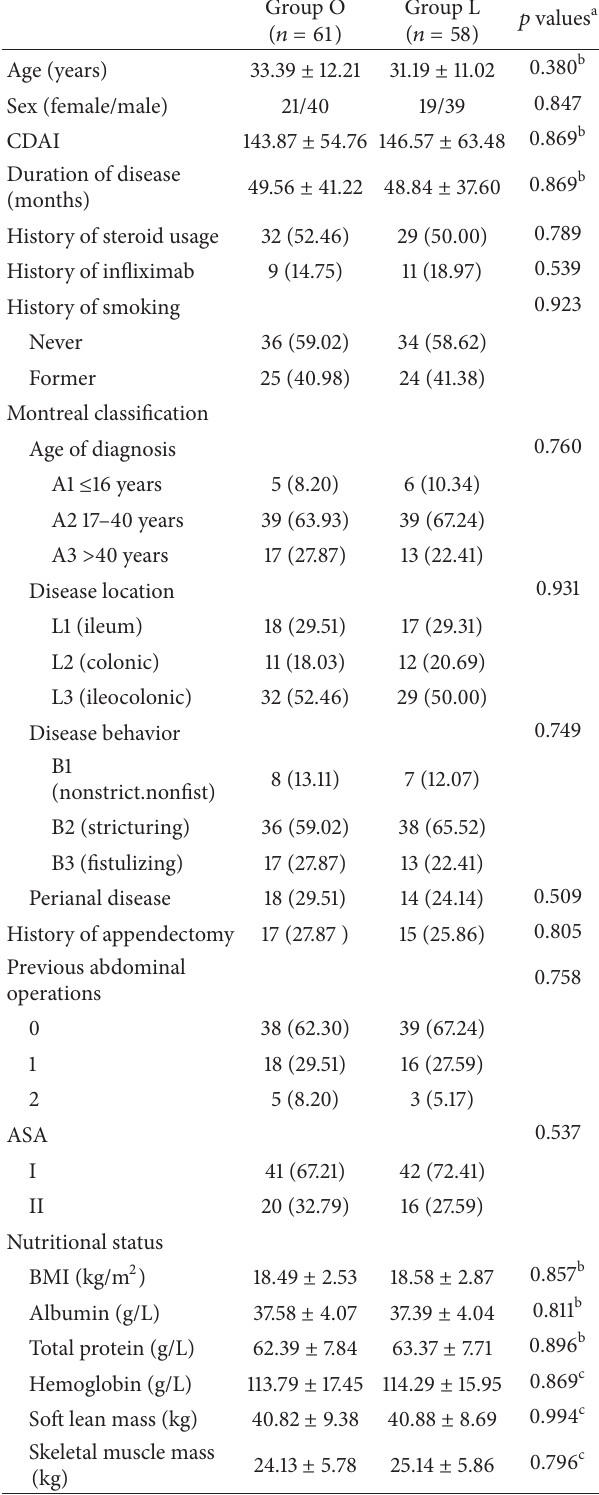
Table 1: The demographic and baseline characteristics of